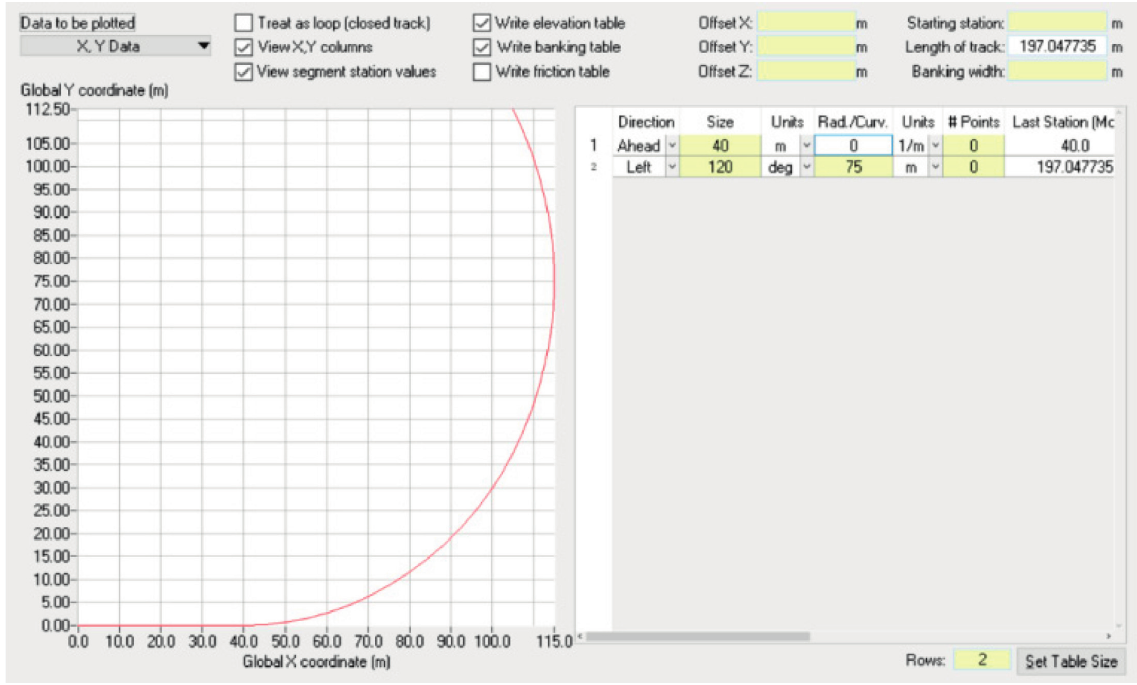
Figure 15: Road simulation settings.